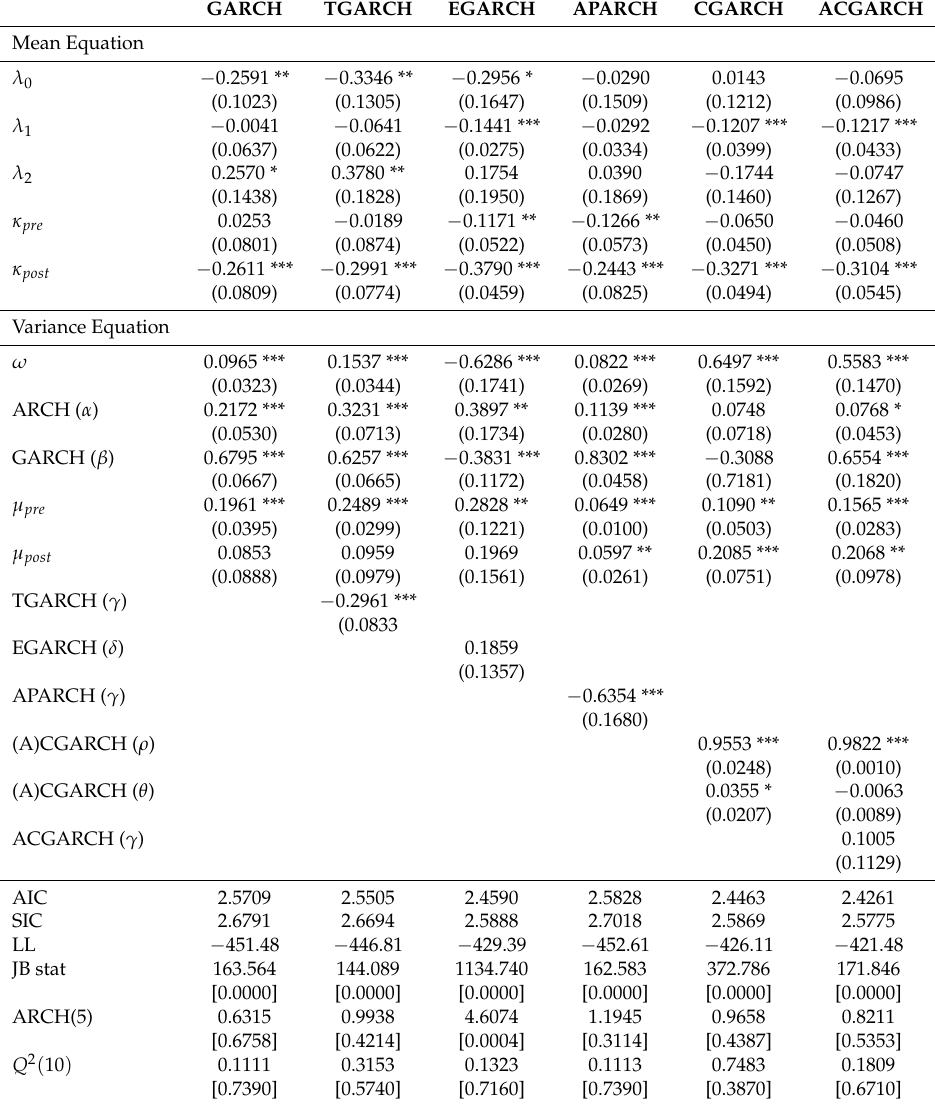
Table A8. GARCH-M Tests for Litecoin for the sample of 360 days.